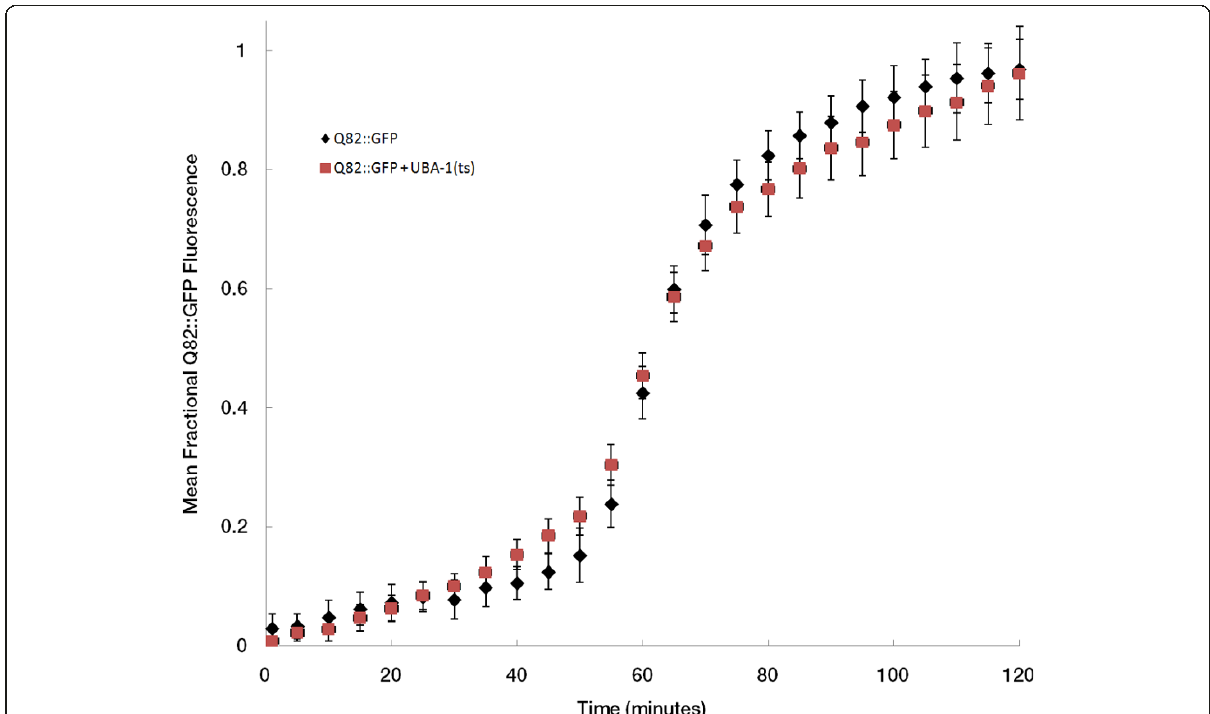
Figure 1 Aggregation profile of Q82::GFP protein in C. elegans . C. elegans larvae expressing a Q82:GFP transgene in a wild type (black diamonds) or in a uba-1 mutant (red squares) were imaged using a microscope with a 10X objective lens at a rate of 1 frame per minute. The sum of the pixel intensity in a square region of the image sequence in which an aggregate formed was measured over time. Plots of individual formation events were aligned along the time axis so that the frame at which the aggregation rate is highest occurs at 60 minutes. For each individual aggregate formation, the fraction of the peak intensity was calculated at each time point. This chart shows the mean (± SEM) fractional aggregate intensity at each time point for a total of 58 aggregate formations in 5 different time-lapse experiments for the Q82 strain in the wild type background and 30 aggregate formations in 3 experiments for the Q82 in the uba-1(ts)